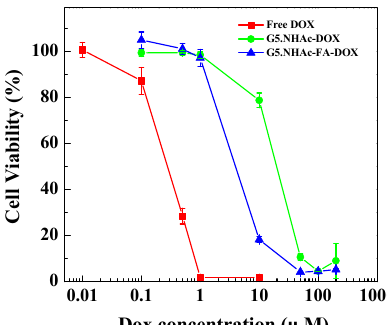
Figure 5. In vitro cytotoxicity of free DOX, G5.NHAc-DOX conjugates, and G5.NHAc-FA-DOX conjugates against KB cells.